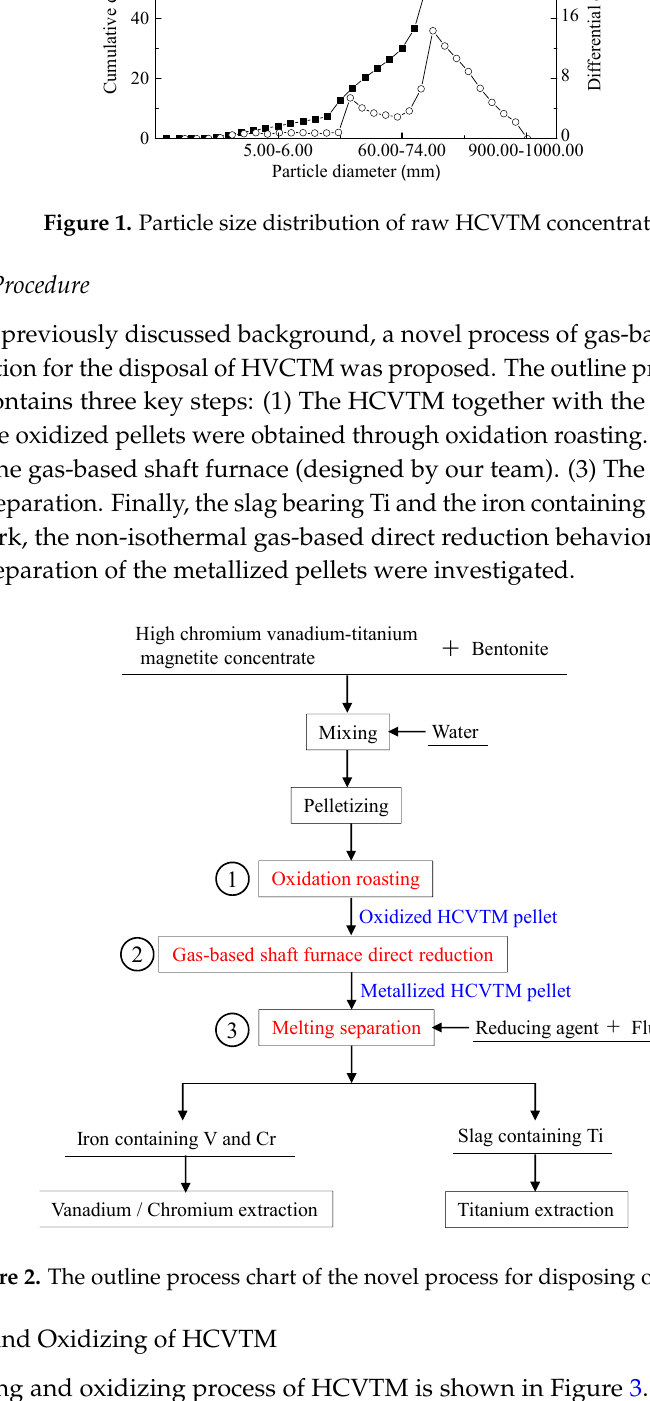
Table 1. Chemical composition of high chromium vanadium-titanium magnetite (HCVTM) and bentonite (wt %).